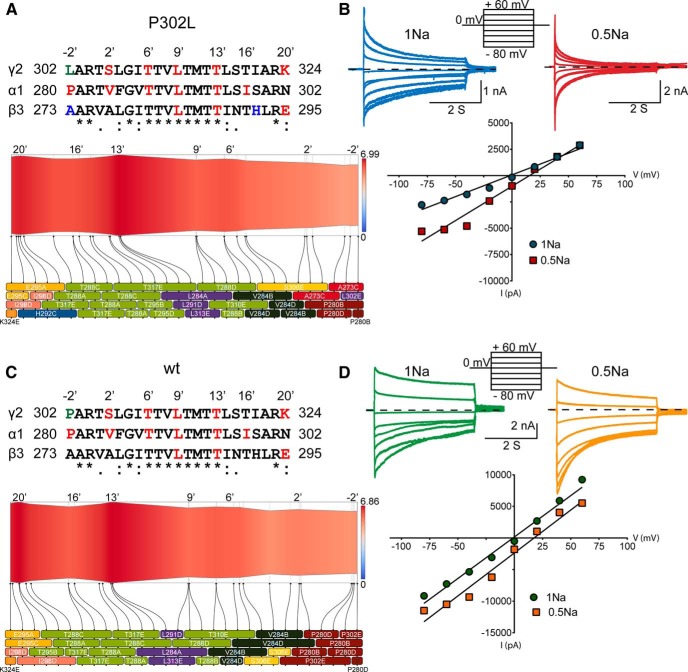
The pore mutation P302L had no effect on GABAA receptor anion selectivity. A, C, Two-dimensional representations of channel radius (in Å) along the pore-axis for both P302L (A) and wt (C) structures in the open state, which was implemented by ChExVis. The analysis showed the pore-lining residues (colored boxes) numbered according to protein sequence and position in M2 of pentameric 3D GABAA receptor structures with the subunit arrangement β3(chain A)-α1(chain B)-β3(chain C)-α1(chain D)-γ2(chain E). Above, alignments of the transmembrane M2 of GABAA receptor γ2, α1, and β3 subunits showed the location and the conservation of the residues within M2 [identical (*), conservative (:), semiconservative (.)]. The residues were in concordance with the boxes below the 2D views. In red were common pore-lining residues that formed part of the inner face of the cavity predicted for both wt and P302L structures, while in blue were those only predicted for the P302L structure. In green, it was the site of the substitution. Below the 2D views, boxes were labeled and colored based on amino acid type as follows: E, glutamic acid (orange); T, threonine (light green); S, serine (yellow); A, alanine (red); I, isoleucine (rose); L, leucine (purple); V, valine (dark green); P, proline (brown); K, lysine (red orange); H, histidine (blue). The suffix after the residue number indicates the subunit to which the residue belongs. The dotted lines connecting the boxes represented the position of the residues along the pore-axis, as indicated on the top of the panels. B, D, Current-voltage (I/V) plots and corresponding GABA-gated peak current responses of mutant γ2L(P302L) (C) and wt (D) α1β3γ2L GABAA receptors obtained from membrane potential range from -80 mV to +60 mV following rapid application of 1 mM GABA for 4s. The traces represented representative individual cells recorded in control (1 Na) or dilute (0.5 Na) solutions to determine the relative permeability of anions of mutant P302L and wt receptors.